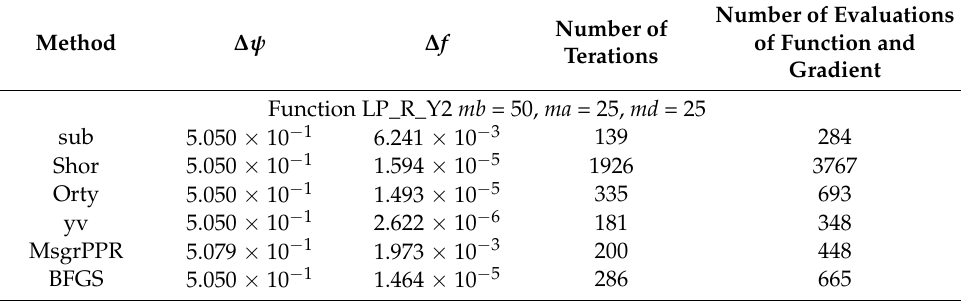
Table 8. Results of calculations for dimensions n = 5000, m = 500 with mb =